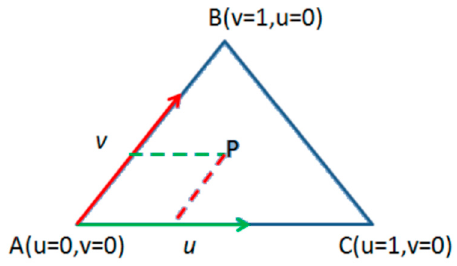
Figure 9. Individual triangle element.